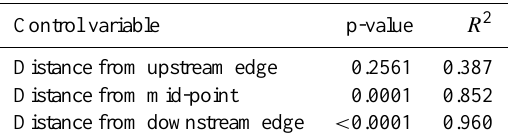
Table 4. Analysis of variance results for obstruction shape versus distance from constriction to the pool center. The distance from the maximum width of the constriction is defined differently for each